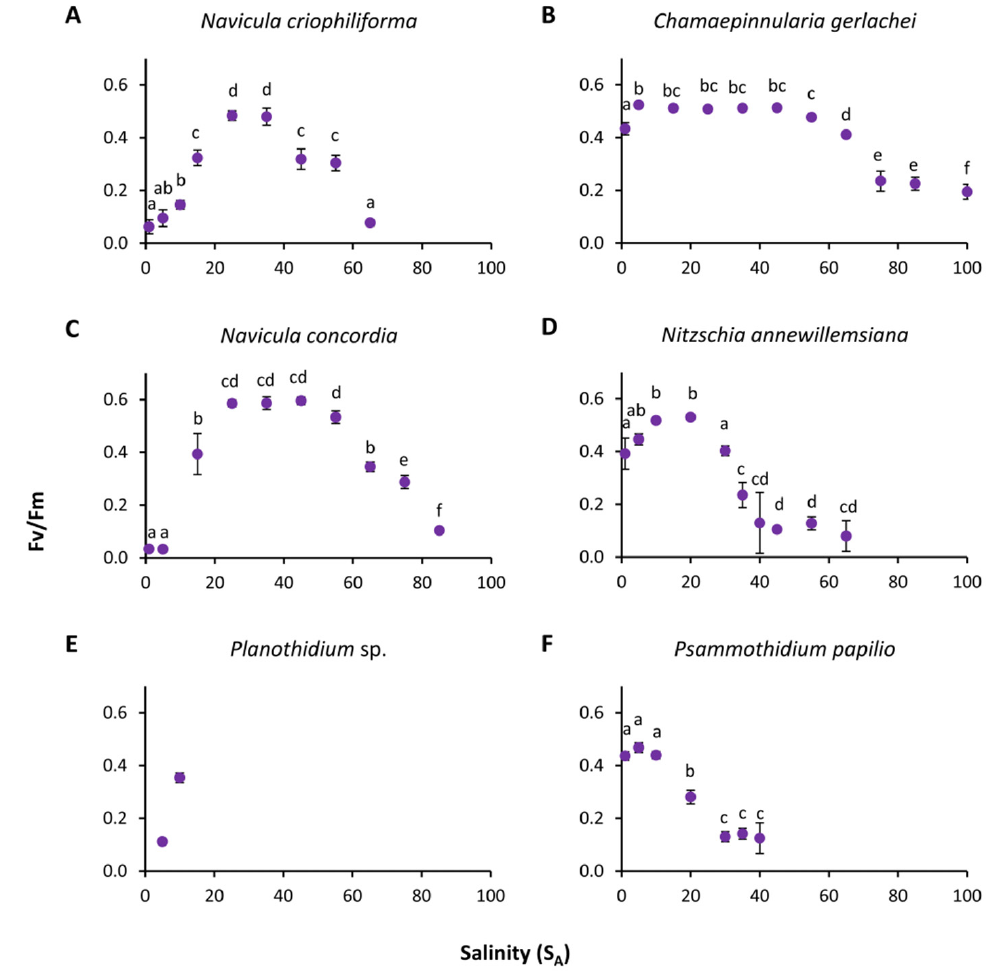
Figure 5. Effective quantum yield of photosystem II (Fv/Fm) as a function of salinity of six benthic diatom strains from Antarctica after 3 days of incubation ( A – F ). Data represent mean values ± SD ( n = 6). Different lowercase letters indicate significant means ( p < 0.05; one-way ANOVA with post hoc Tukey’s test). ( A ) Navicula criophiliforma , ( B ) Chamaepinnularia gerlachei , ( C ) Navicula concordia , ( D ) Nitzschia annewillemsiana , ( E ) Planothidium sp., and ( F ) Psammothidium papilio .